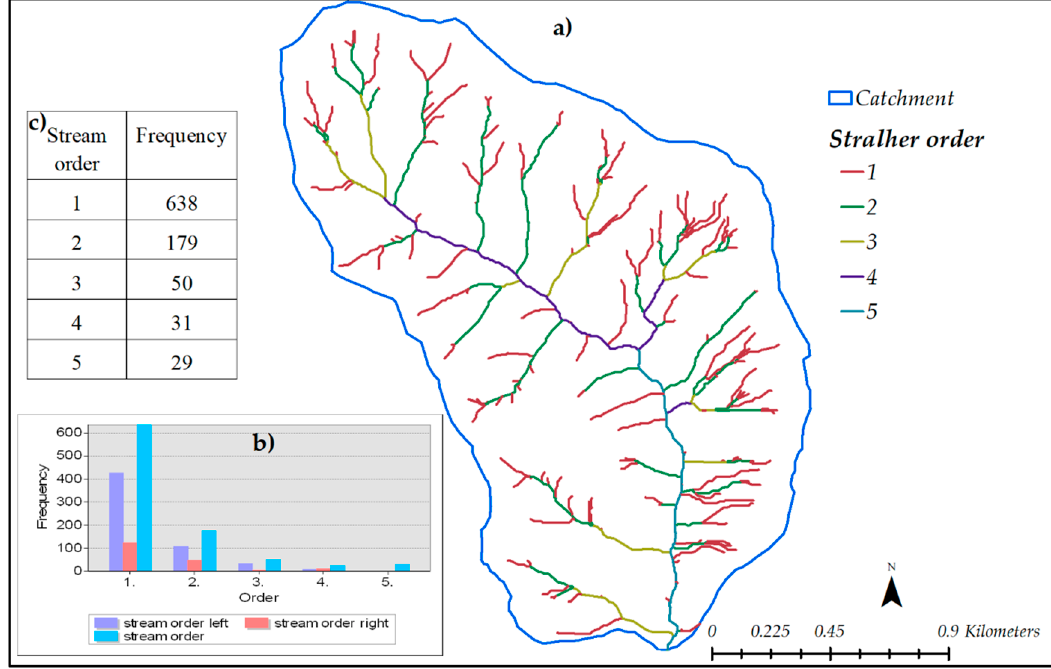
Figure 8. Hydrographical network of the Ciciriello catchment. Strahler order ( a ), stream order frequency distribution on the whole catchment and on the left and right valley ( b ) and stream order frequencies on the whole catchment ( c ).